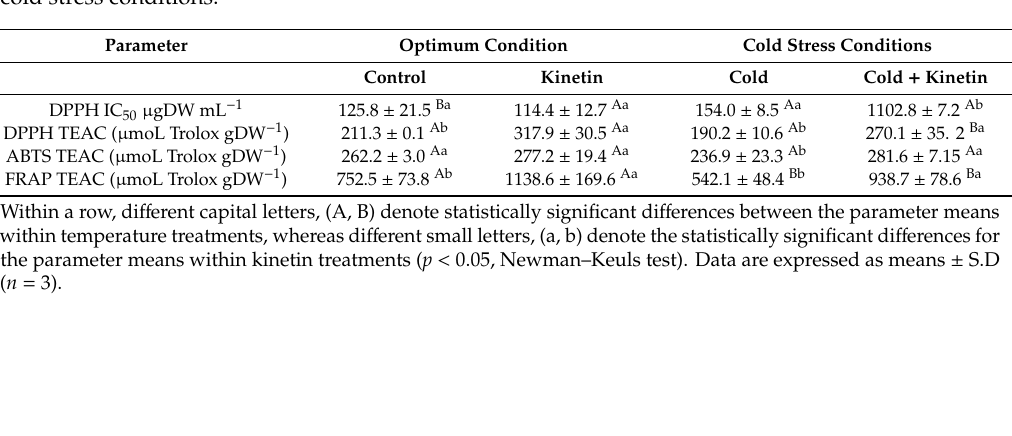
Table 4. E ff ect of exogenous kinetin on the antioxidant activities of co ff ee leaves under optimum and cold stress